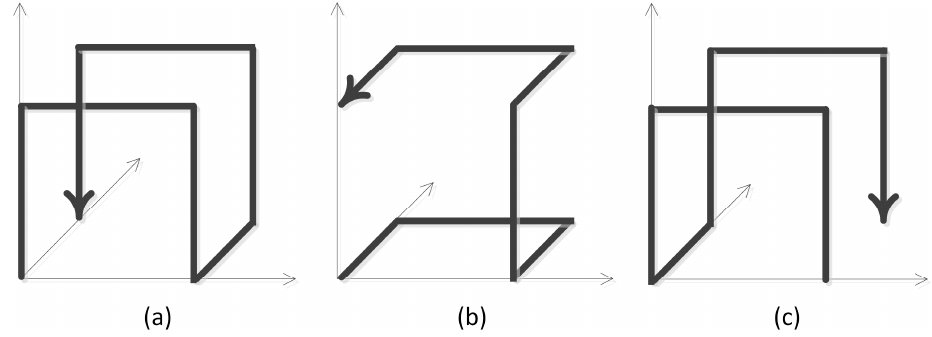
Figure 1. Three-dimensional Hilbert curve unit coordinate transformation. ( a ) Initial state; ( b ) after exchanging; ( c ) after reversing.